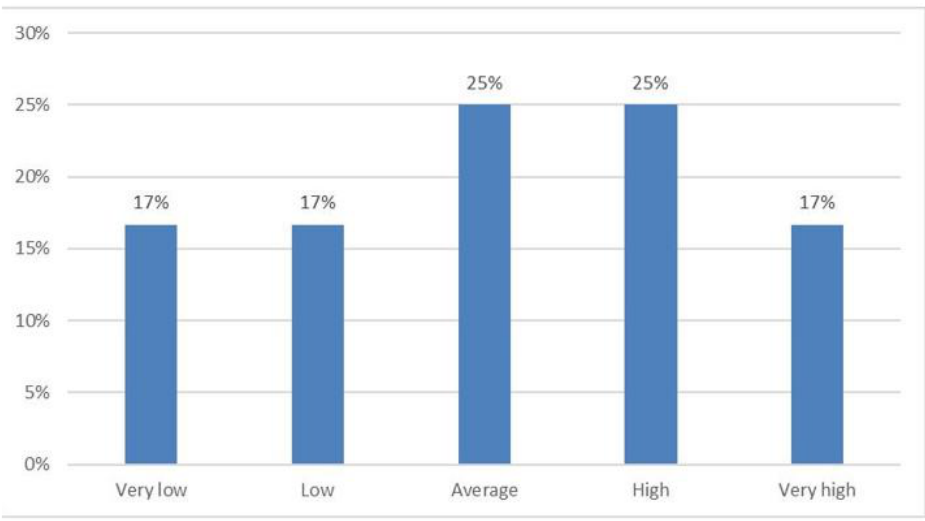
Figure 14. Delays in Shipments and Moving Cargo Processes (%)